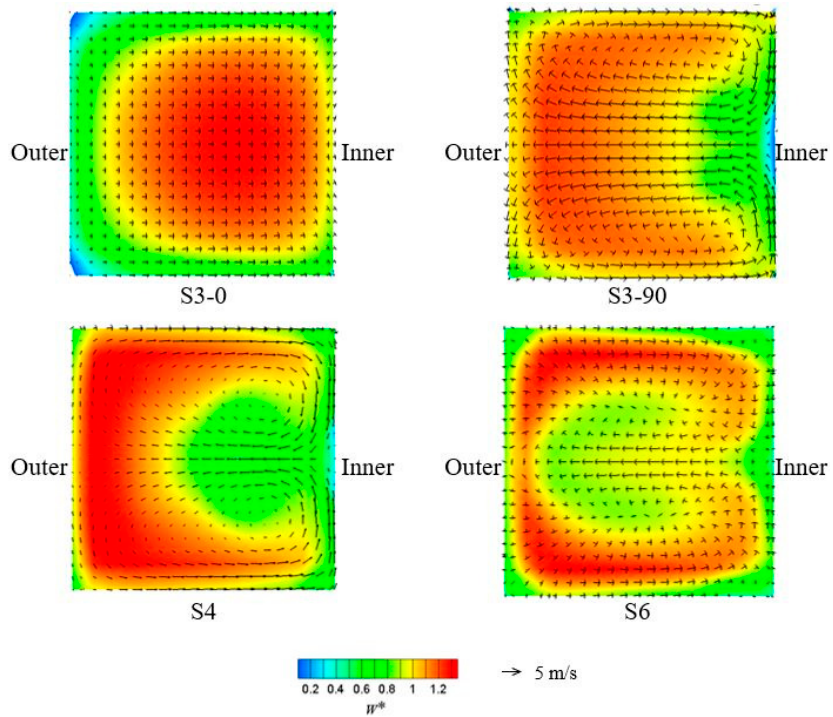
Figure 11. Time-averaged velocity fields of various cross-sections from numerical data. Contours indicate normalized streamwise velocity W* = W/W b , where W is the streamwise velocity, and W b is the time-averaged bulk velocity. Vectors indicate in-plane velocities.